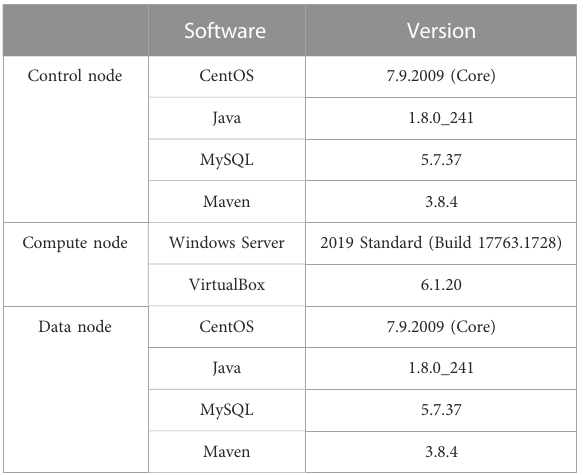
TABLE 2 Con fi guration table of software